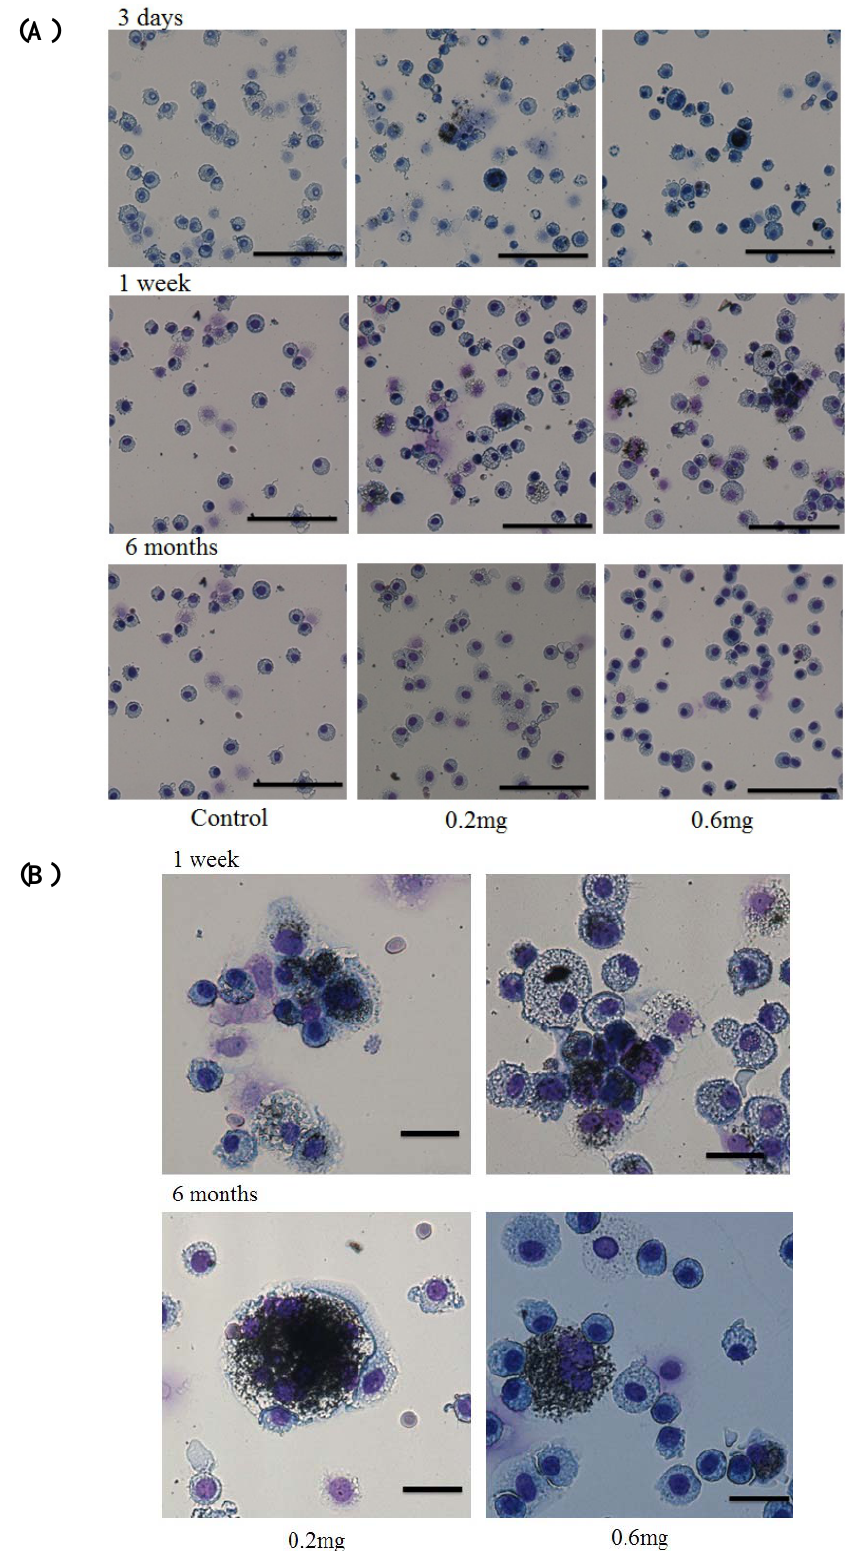
Figure 4. Observation of cells in the BALF and uptake of CNT by macrophages. ( A ) Light micrograph of total cells in the BALF. Bar = 100 µm; ( B ) Light micrograph of macrophage in the BALF at 3 days, 1week, and 6 months after instillation was shown. Bar = 20 µm. The cells in the BALF were stained by Diff-Quick stain. Phagocytosis of CNT by macrophage was